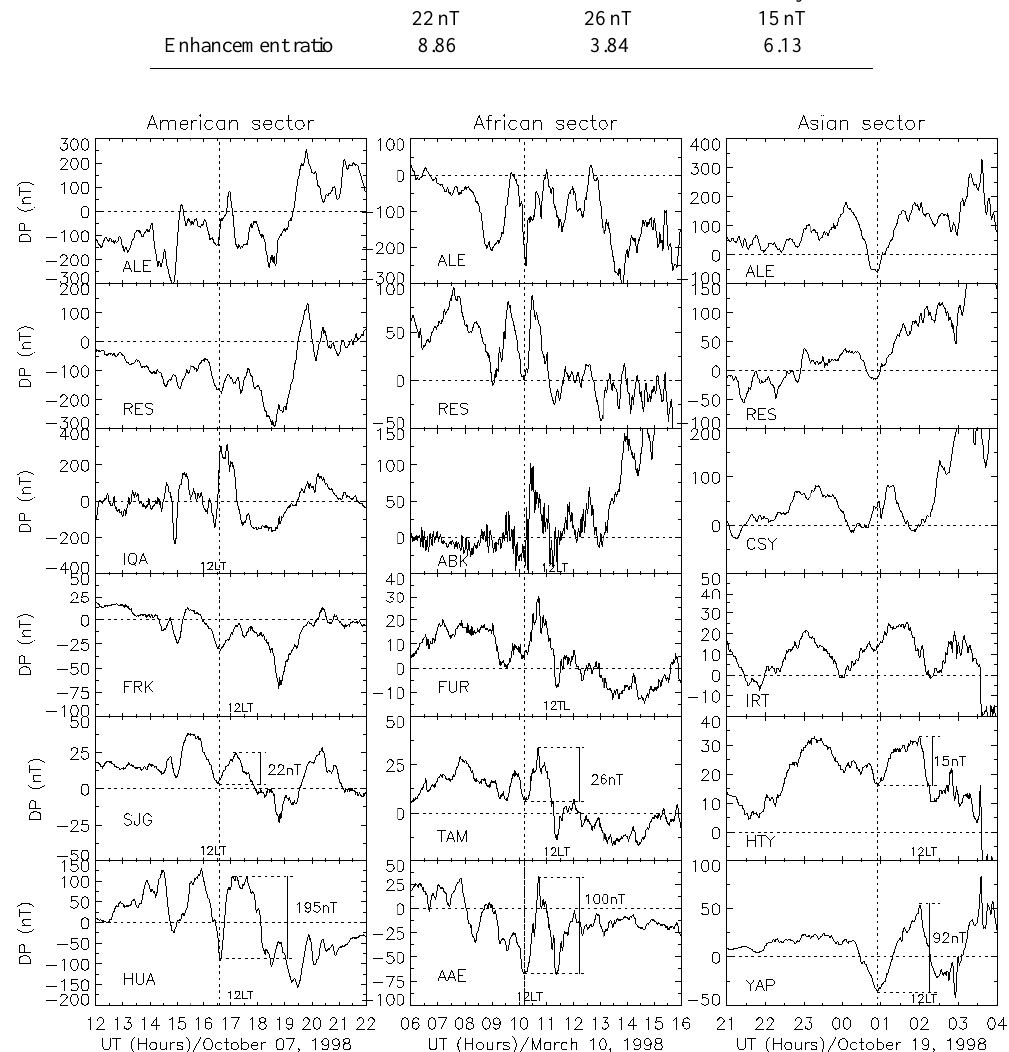
Fig. 6. Variation of H-component disturbance (DP) from high latitude to dip-equator on 7 October 1998 (American sector), 10 March 1998 (African sector) and 19 October 1998 (Asian